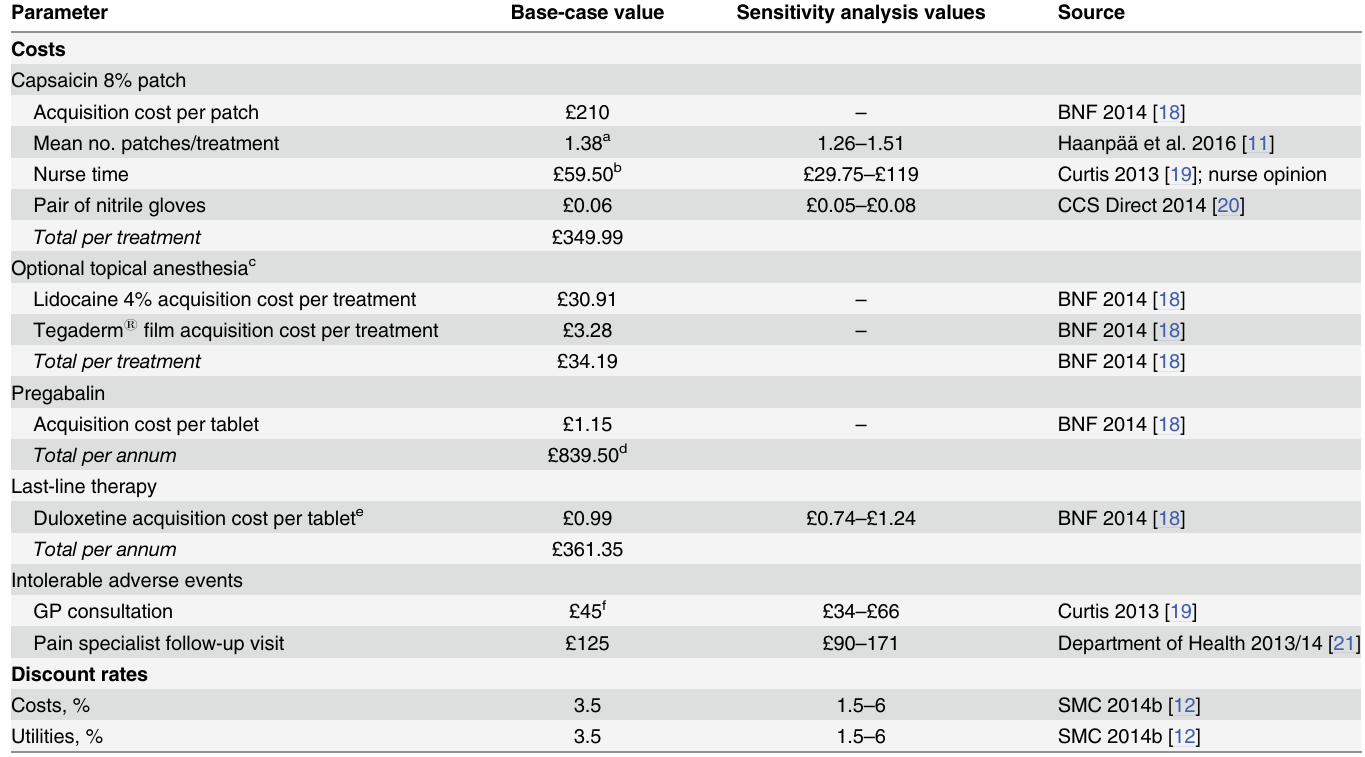
Table 2. Model inputs: